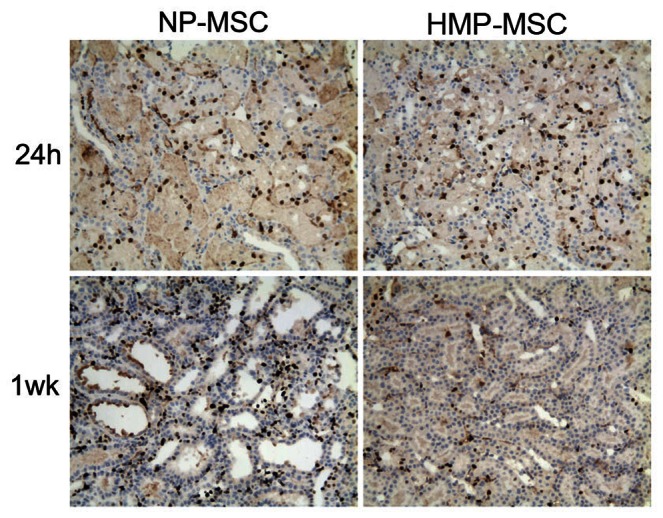
Tubulointerstitial cell proliferation after MSC injection.Cell proliferation was analyzed immunohistochemically by Ki-67 staining. At 24 h after MSC injection the number of Ki-67 positive cells was higher in HMP-MSC group than in NP-MSC group, with most of these cells localized in tubules. Conversely, the number of Ki-67 positive cells was lower in HMP-MSC group than in NP-MSC group 1 week after injection, and most of the positive cells were located in interstitium. (Magnification ×200).